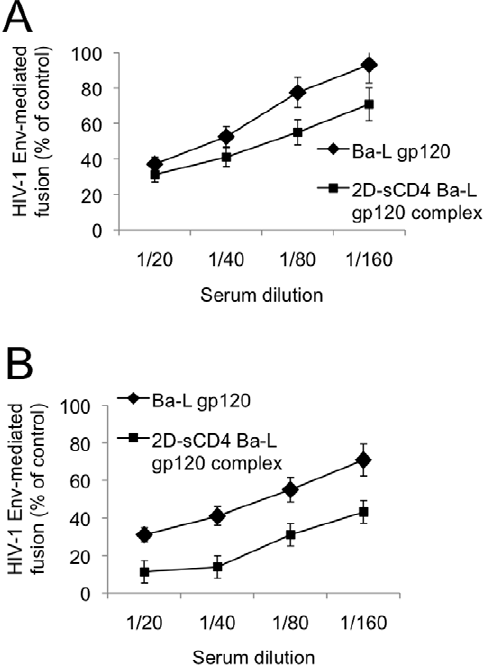
Figure 3. Biological effects of sera derived from mice immunized with CD4-complexed HIV-1 Env. A. Binding of pooled sera derived from mice immunized with HIV-1 Env in complex or not with soluble CD4 to solid phase gp120 (from isolate HIV-1 Ba-L). B . Inhibition of phosphatase-labeled Ba-L gp120 binding to solid-phase 2D-sCD4 by sera from mice immunized with HIV-1 Env in complex or not with soluble CD4. The phosphatase activity, measured by the rate of PNPP hydrolysis, is expressed as percent of the positive control (no serum added).